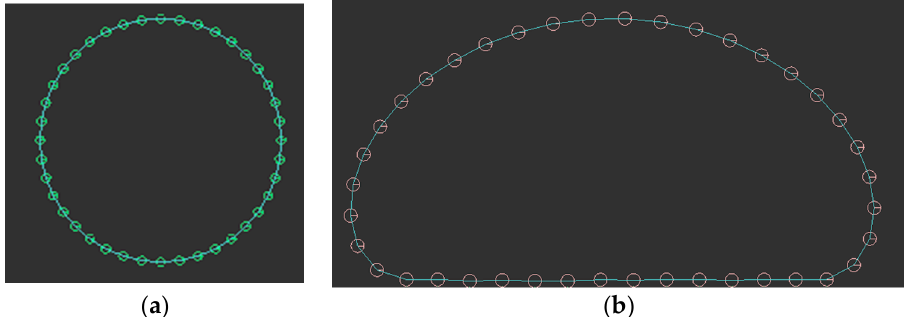
Figure 2. ( a ) Soft body in the beginning; ( b ) soft body after several steps of Algorithm 1.